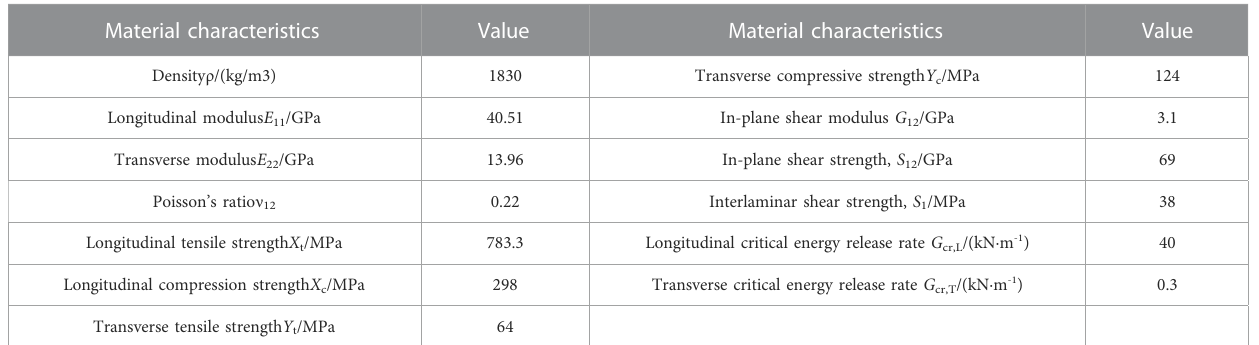
TABLE 2 Characteristic parameters of composite